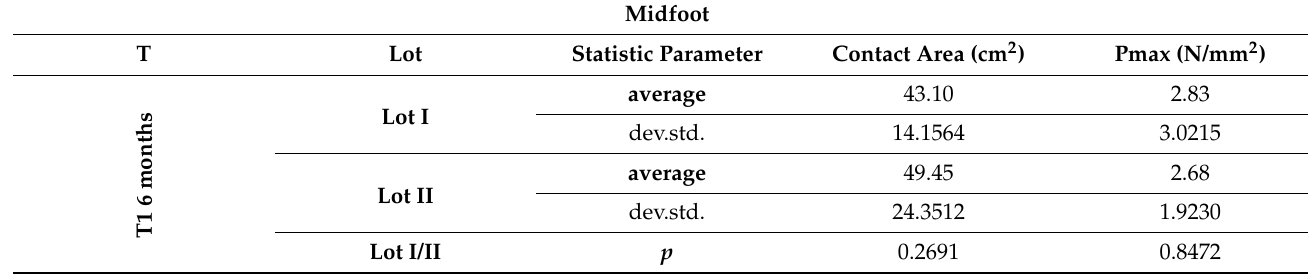
Table 5. Average values for midfoot, 6 months and 1